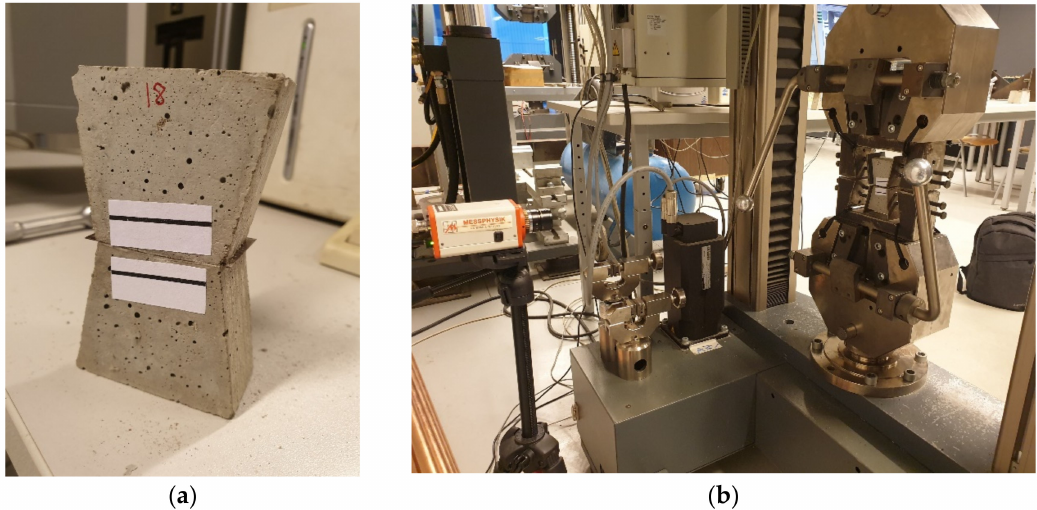
Figure 12. ( a ) Pull-out sample; ( b ) Single steel fiber pull-out testing process.